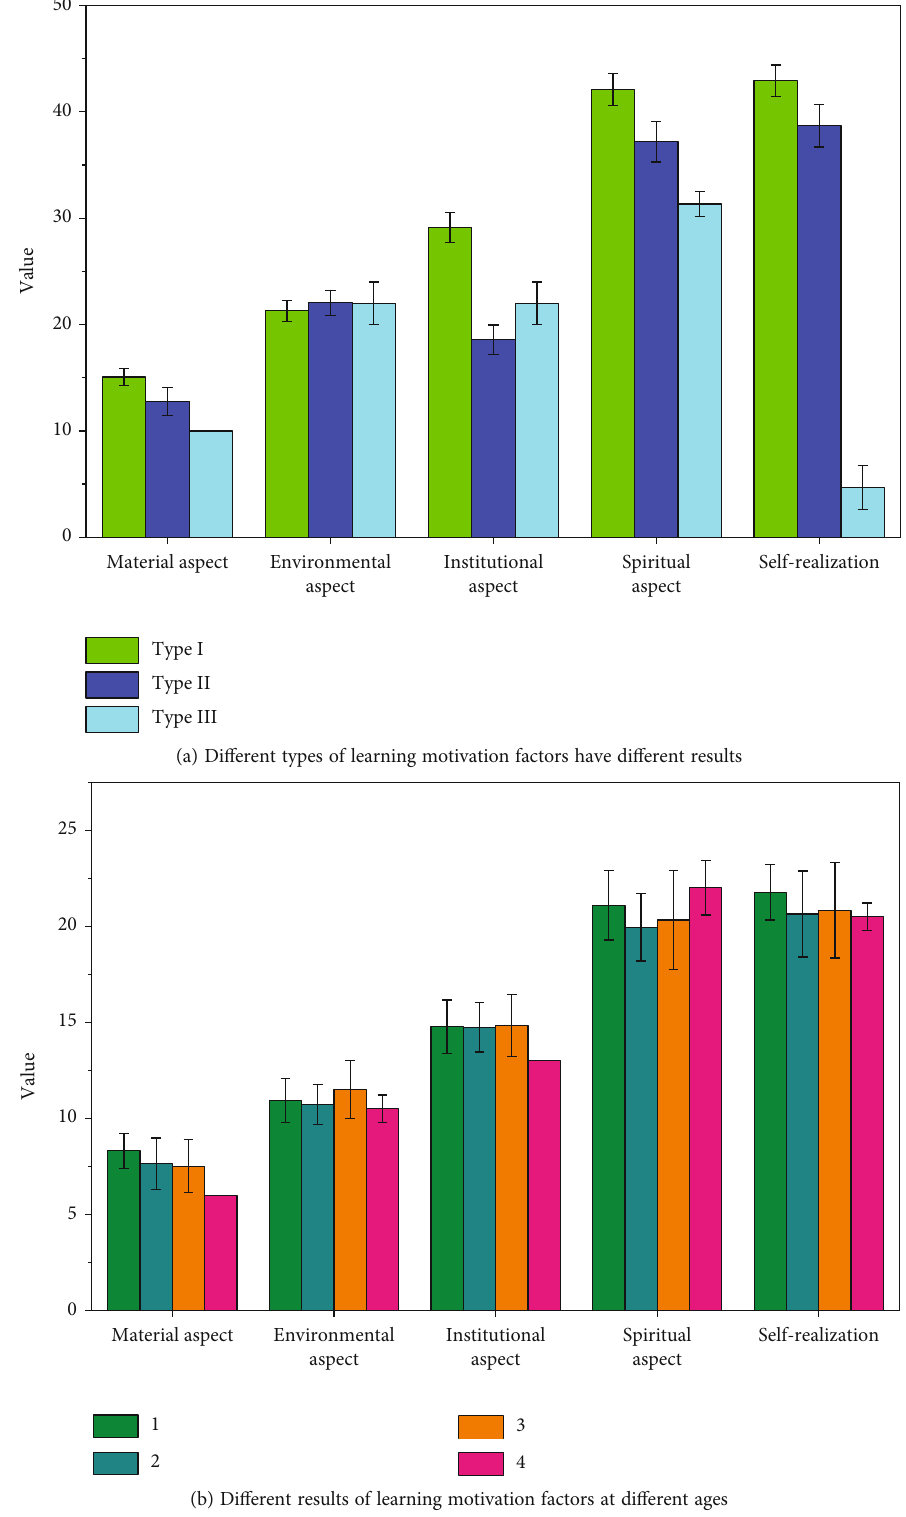
Figure 4: Variance results of learning motivation